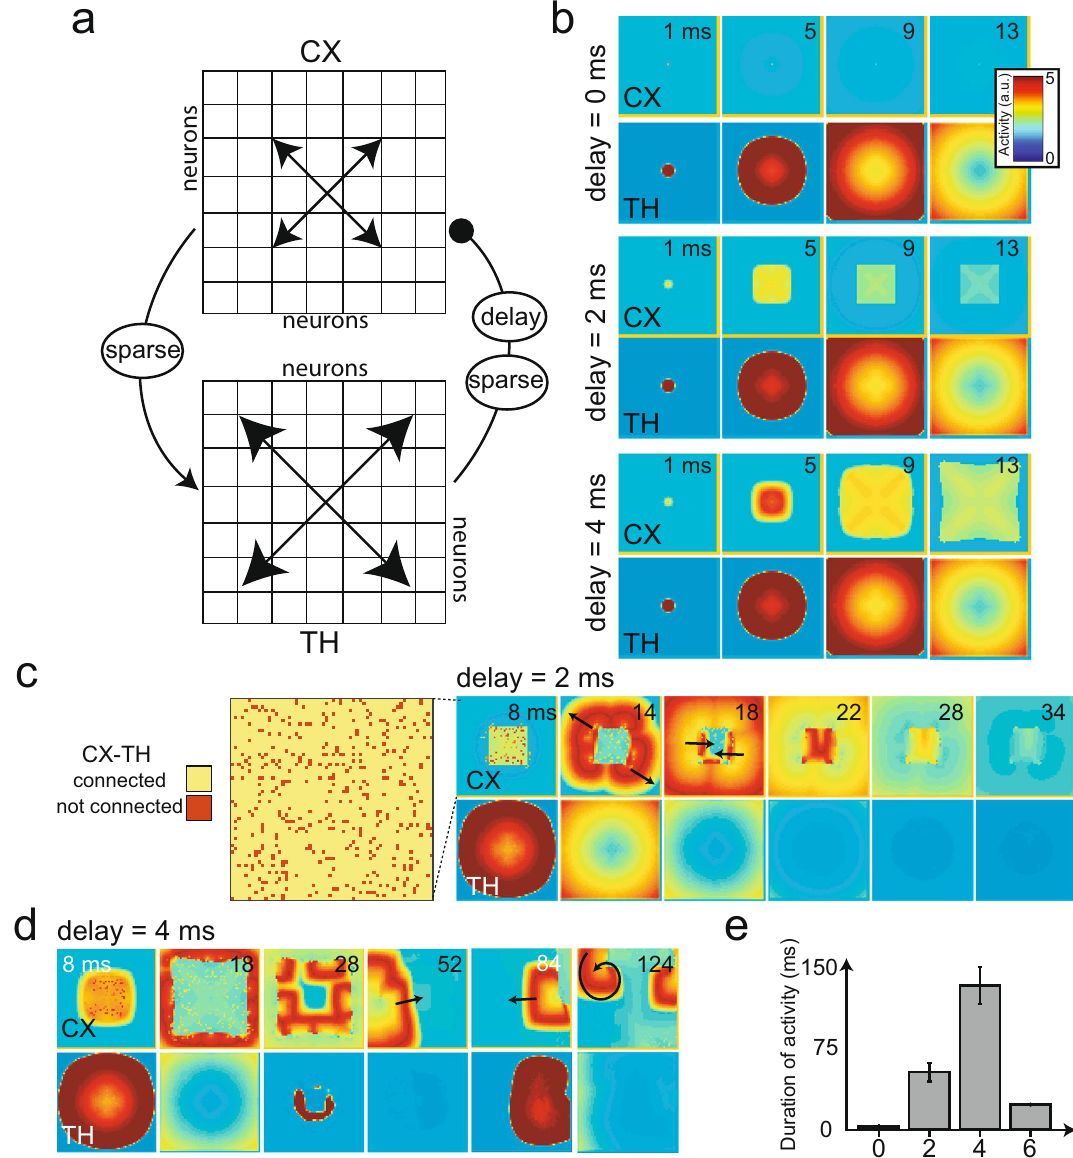
Figure 4. Transmission delay between the cortex and thalamus changes the stimulus-evoked traveling wave patterns. ( a ) A reduced thalamocortical model showing interactions between CX and inhibitory TH cells with lateral connections. The grid denotes the 2D neuron array layout. A nonzero delay parameter was introduced between TH and CX connection to account for axonal conduction delays. We assumed that CX was fully connected with purely excitatory neurons. ( b ) Impact of different thalamocortical delay parameters on the CX wave dynamics (assuming fully connected TH-CX). With an increased delay, the CX wave could propagate further and longer. In contrast, lateral excitation allowed the TH wave to propagate unrestricted regardless of the delay. Colors denote activity levels. ( c ) A 90% connected TH-CX condition, where the red dots denote the cortical neurons that receive no TH inhibition. For a specific thalamocortical delay of 2 ms, the uninhibited points produced a new CX wave that propagated in various directions (indicated by black arrows), and TH wave activity ultimately disappeared. ( d ) With an increased delay of 4 ms, dynamic wave activity emerged. In 8 ms), planar ( t 52 ms), and rotating ( t 124 ms) waves were produced. ( e ) this illustration, radial ( t = = = Comparison of the wave activity duration with respect to different delay parameters. Their non-monotonic relationship suggests an optimal delay regime in the thalamocortical network. Error bar represents